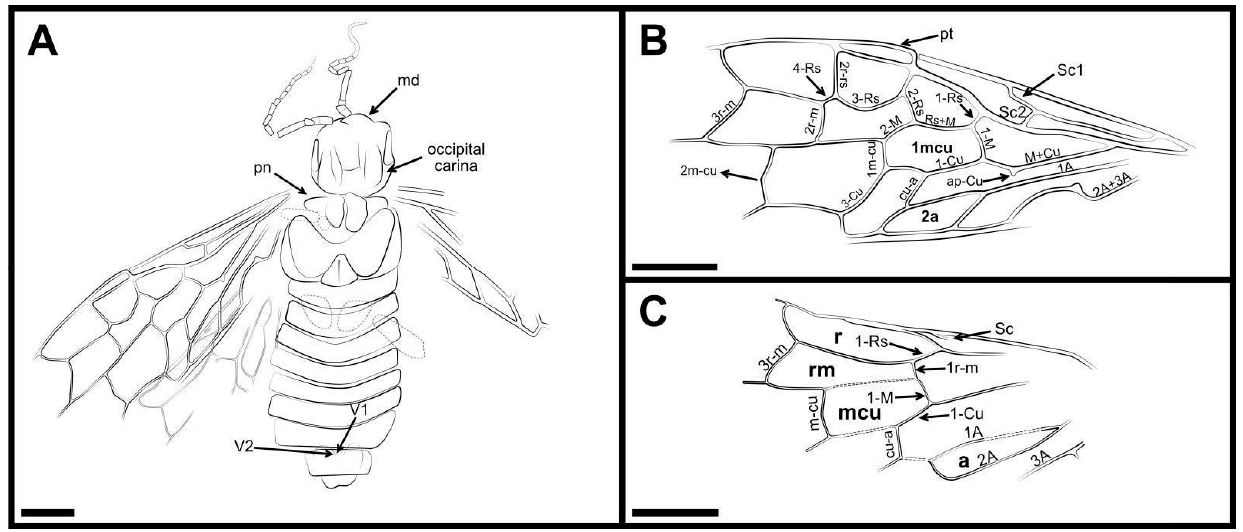
Figure 2. Dolicholyda obtusata gen. et sp. nov., ( A ), line drawing of ventral view. ( B ), line drawing of forewing. ( C ), Reconstruction of the hind wing venation (mirror flip for the anal field). Symbols: md = mandible; pn = pronotum; v1, v2 = 1st and 2nd valvifer; pt = pterostigma. Cell names are in bold. Scale bars: 2 mm in ( A – C ).